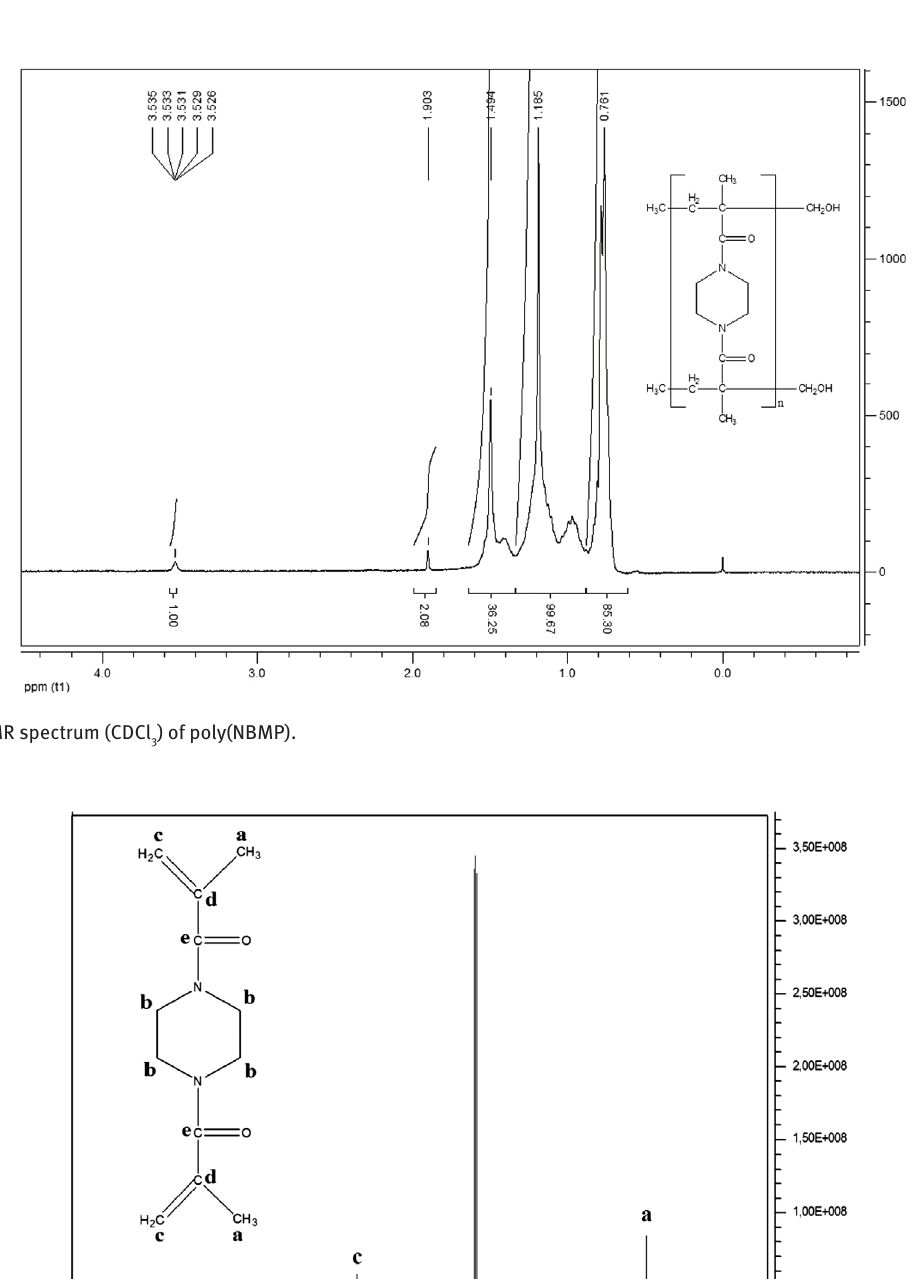
Figure 9: 13 C NMR spectrum (CDCl